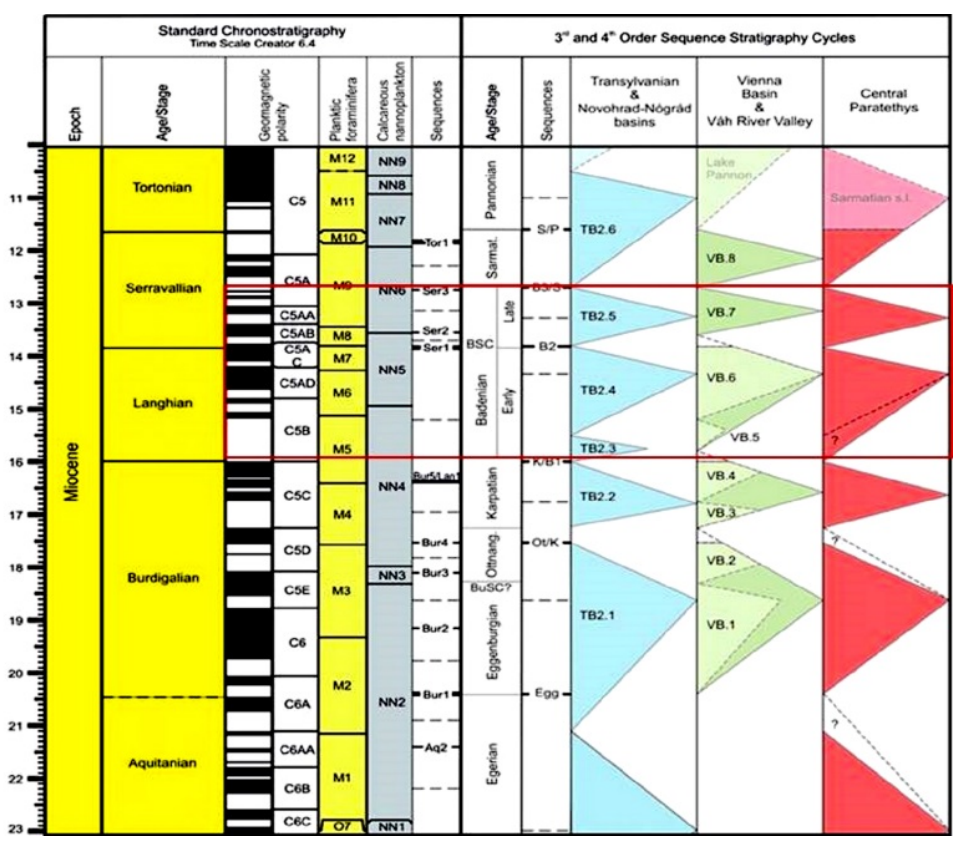
Figure 4. Central Paratethys sequence stratigraphy (after [2,66–68] from [4]). Badenian Stage, the most relevant for this paper, is within the red rectangle.